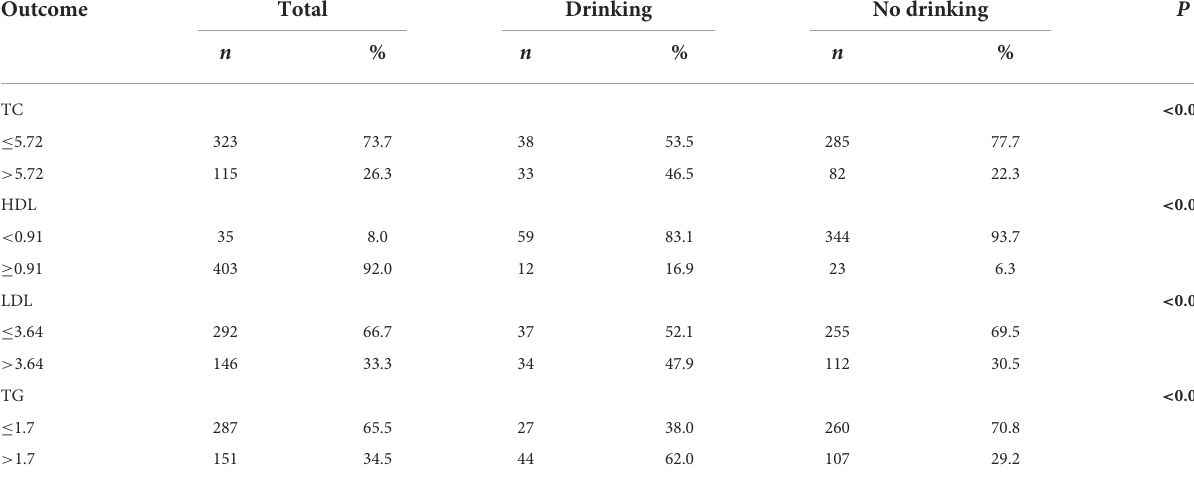
TABLE 2 The blood lipid distributions according to drinking status. Outcome Drinking